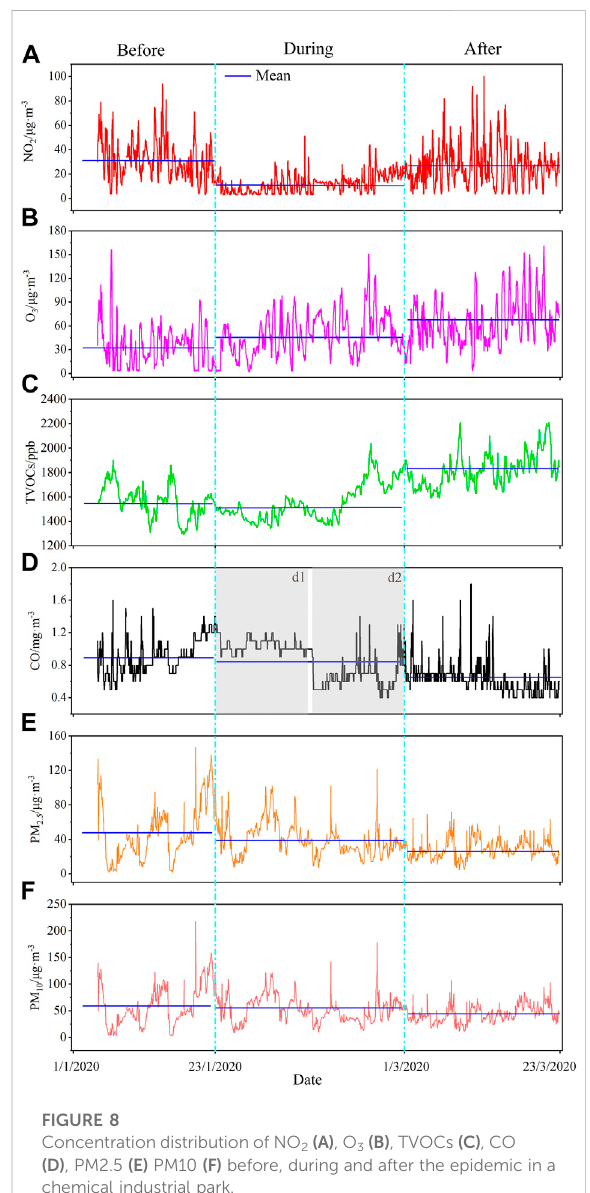
FIGURE 8 Concentration distribution of NO 2 (A) , O 3 (B) , TVOCs (C) , CO (D) , PM2.5 (E) PM10 (F) before, during and after the epidemic in a chemical industrial park.